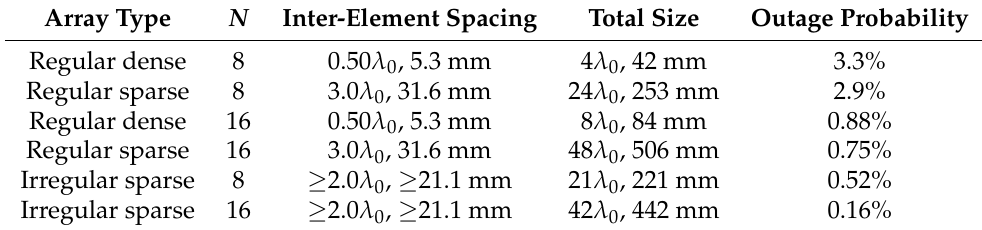
Figure 4. Cumulative distribution function of the CNR for regular and irregular (random) arrays. The improvement in terms of outage probability is substantial when considering random arrays, for both cases where N = 8 and N = 16. The sizes are 21 λ 0 for both N = 8 arrays and 42 λ 0 for both N = 16 arrays. K = 2 for both cases. Table 2. Array parameters and calculated outage